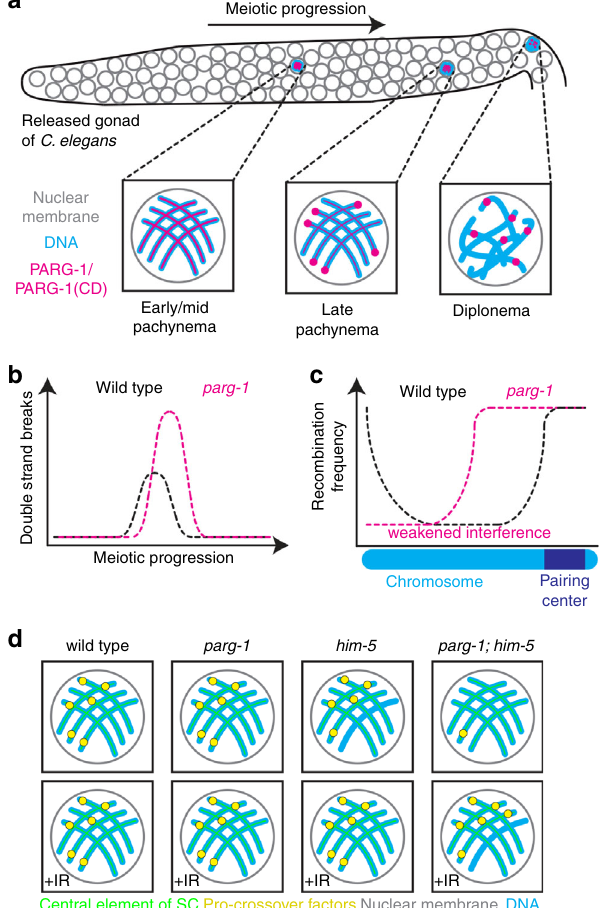
Fig. 7 Graphic schematization of possible PARG-1 modes of